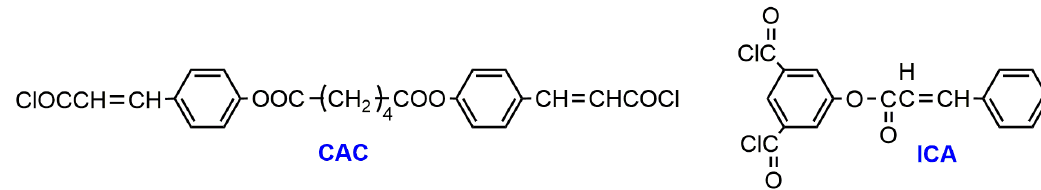
Figure 5. Compounds used for polycondensation with PLA diols.